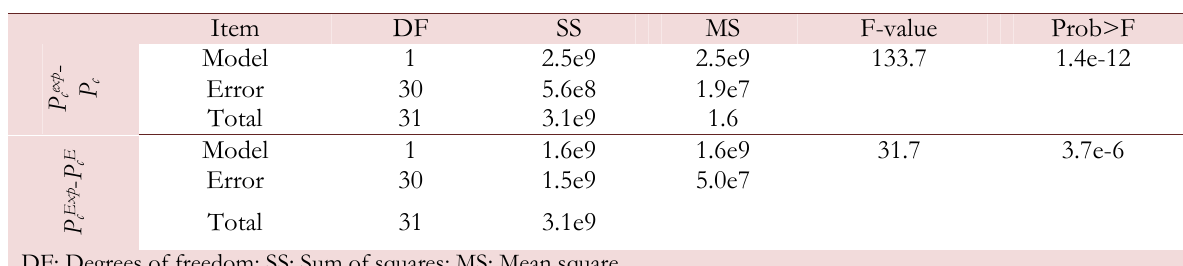
Table 3: The regression analysis results of the PCF obtained from different method.